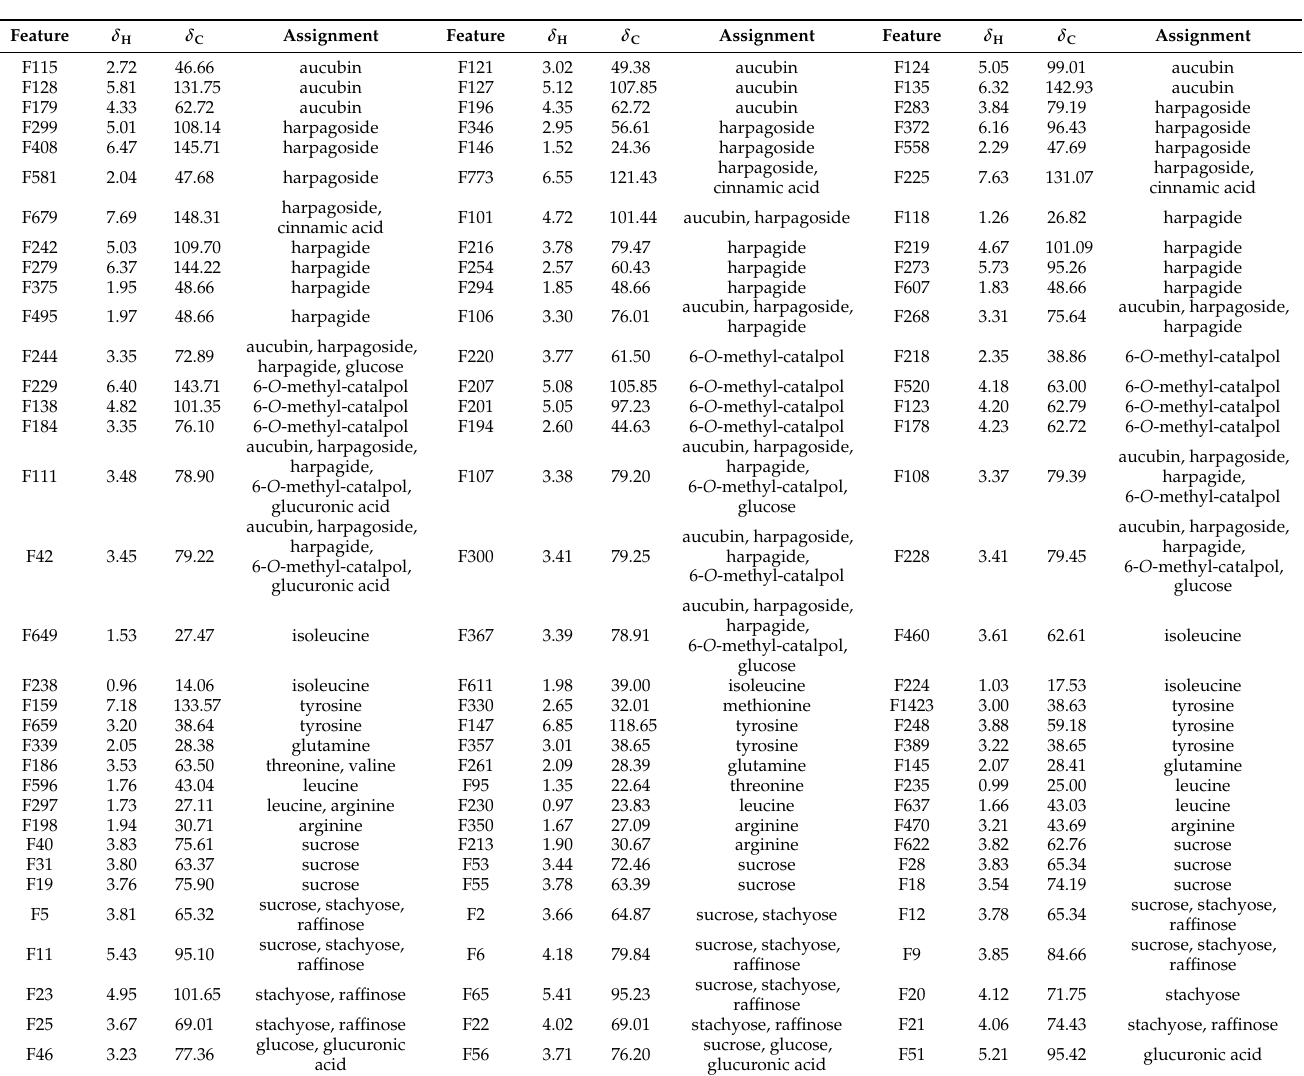
Table 1. Detailed information and assignments of the differential features (F) among samples of SR steamed for different durations with VIP > 1.1 and | p (corr)| > 0.9 by OPLS-DA and p value < 0.01 using univariate Student’s t